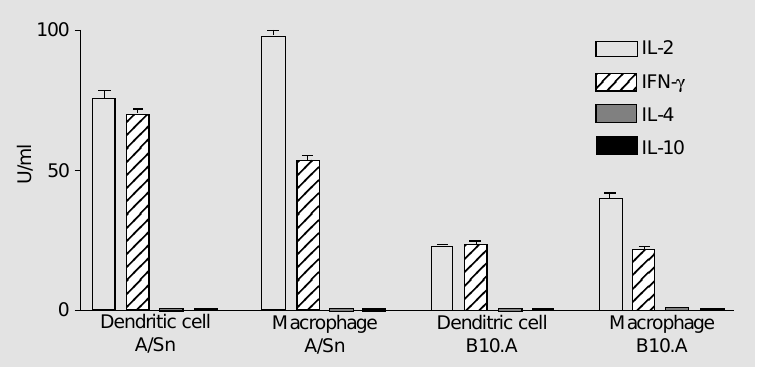
Figure 4 - Lymphokine profiles of T cells from A/Sn or B10.A mice stimulated with gp43 (10 µg/ml) in the presence of syngeneic dendritic cells or macrophages. Supernatants were assayed by ELISA for the presence of IL-2, IFN- g , IL-4 and IL-10. The levels of cytokines in the absence of gp43 were: A/Sn (dendritic cell, IL-2: 6 U/ml, IFN- g : 6.5 U/ml; macrophage, IL-2: 3 U/ml, IFN- g : 4.5 U/ml) and B10.A (dendritic cell, IL-2: 3 U/ml, IFN- g : 4 U/ml; macrophage, IL-2: 3 U/ml, IFN- g : 4.5 U/ml). Results are representative of three independent